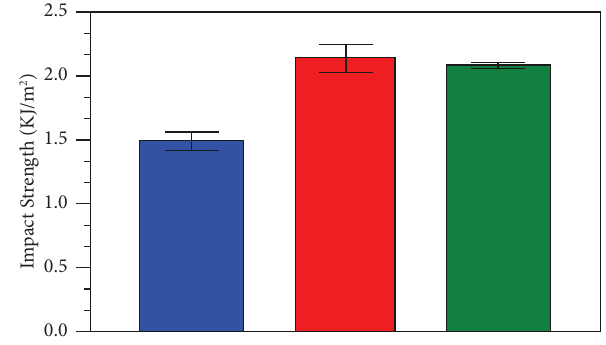
Figure 4: Impact test